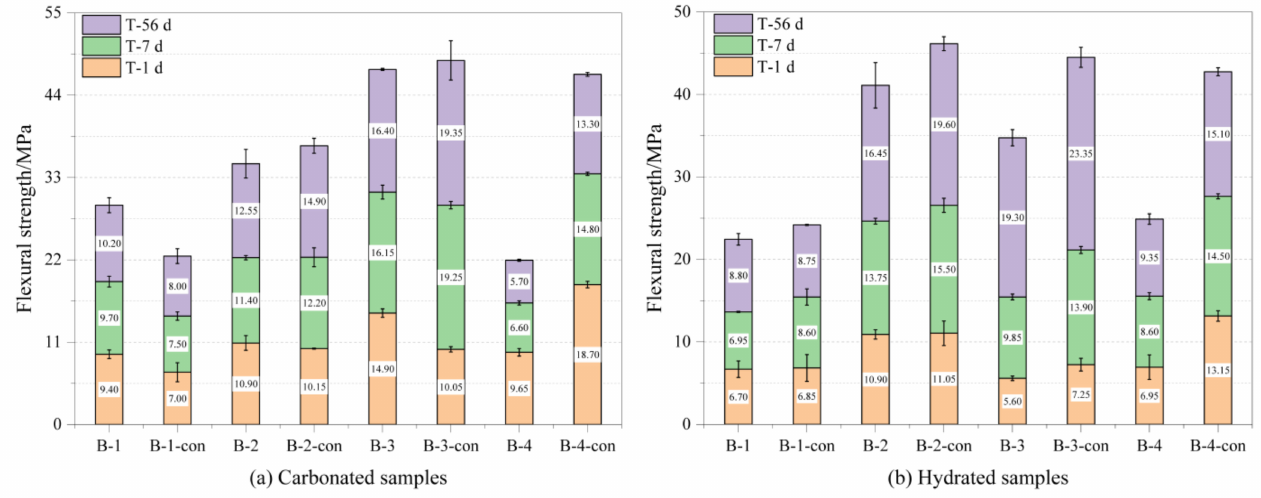
Figure 7. Flexural strength of carbonated and hydrated specimens. ( a ) Carbonated samples; ( b ) Hydrated